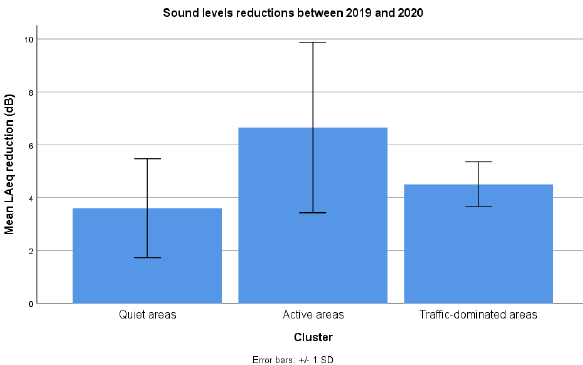
Figure 8: Mean A-weighted equivalent sound level reductions be- tween the pre- and during-lockdown conditions as a function of cluster membership ( i.e. , Area